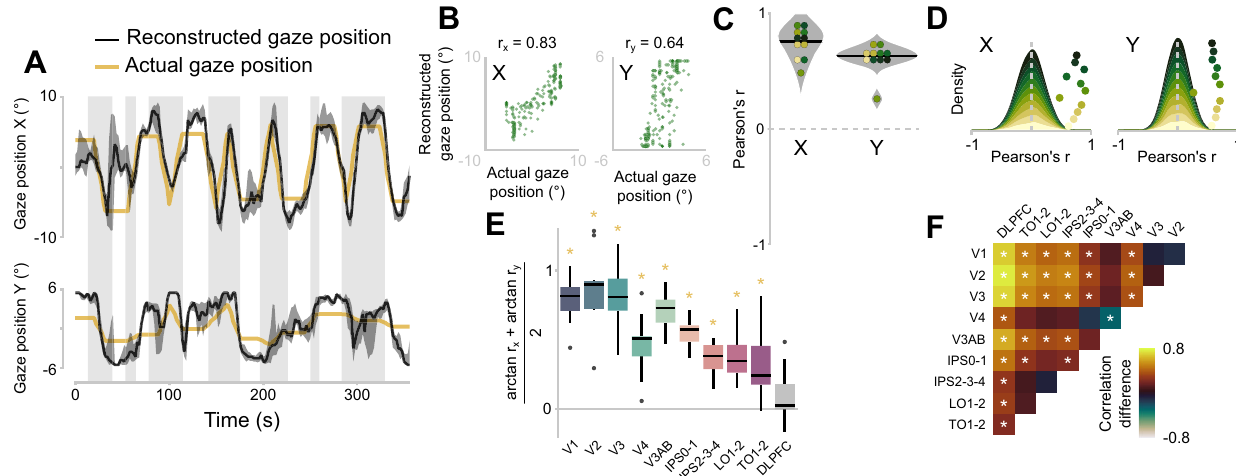
Fig. 4 | Eye position reconstruction. A Horizontal (top) and vertical (bottom) components of the median reconstructed eye position (black) and actual target position (yellow) of version B of the eye-movement task. Reconstruction was per- formed using all visual ROIs. Dark gray shaded area represents the interquartile range. Gray rectangles are periods when the fl ickering bars were on the screen. B Scatter plots of reconstructedeye position against the actualeye position for an example participant. C Pearson ’ s correlation coef fi cients for all participants (points). Violinsrepresent kerneldensityestimates.Blacklineisthegroup median. D Stacked kernel density estimates of the correlation coef fi cients from the per- mutation ( N =1000). Colors represent single participants. Points represent the correlationsobtainedwith the true, estimated pEGFparameters(sameisinC).The height of the points is arbitrary but follows the order of the stacking of the kernel density estimates. E Correlations between actual eye position and reconstructed positions from single visual ROIs and a control area in the dorsolateral prefrontal cortex (DLPFC). The horizontal and vertical components were combined into a